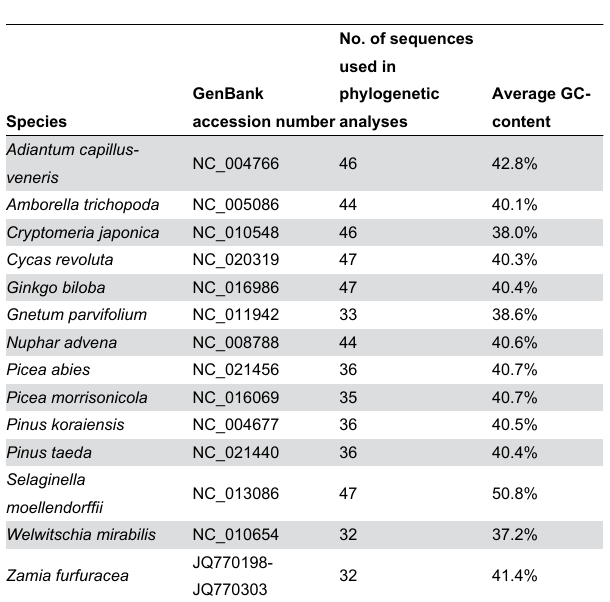
Table 2. Data sources of plastid gene sequences included in our phylogenetic